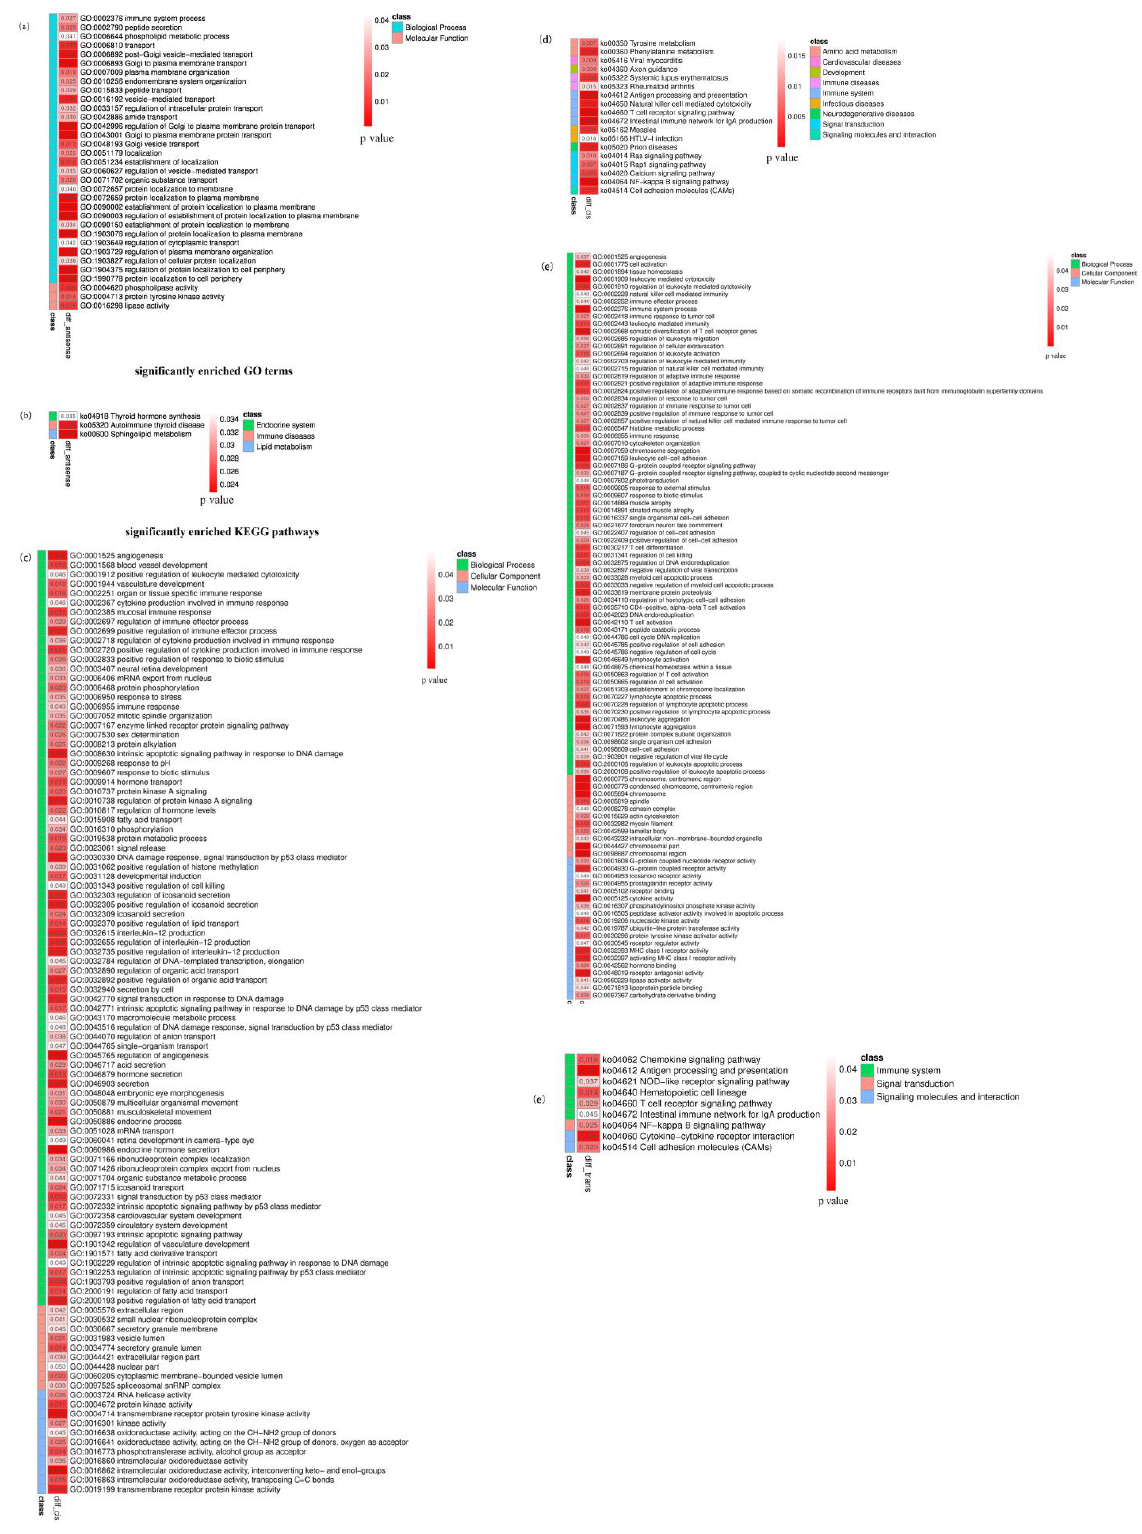
Figure 5. GO and KEGG pathway enrichment analyses of lncRNA targeted mRNAs with different interaction modes. ( a , b ) GO and KEGG pathway enrichment analyses of antisense lncRNA target mRNAs. ( c , d ) GO and KEGG pathway enrichment analyses of lncRNA cis-regulated target mRNAs. ( e , f ) GO and KEGG pathway enrichment analyses of lncRNAs that trans-regulate target